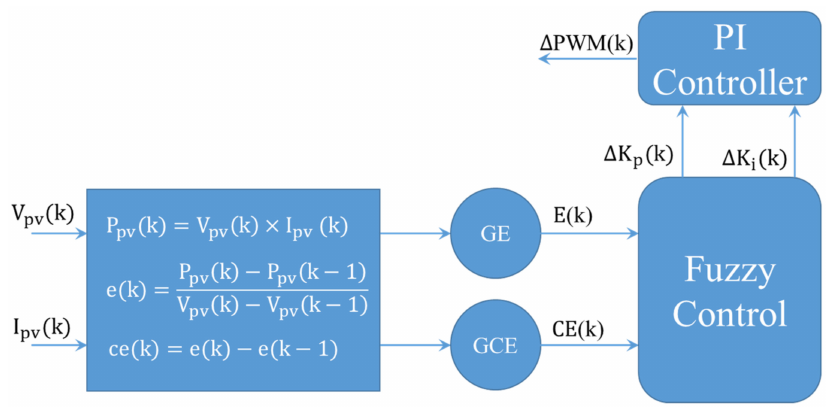
Figure 18. PI controller and Fuzzy control combination